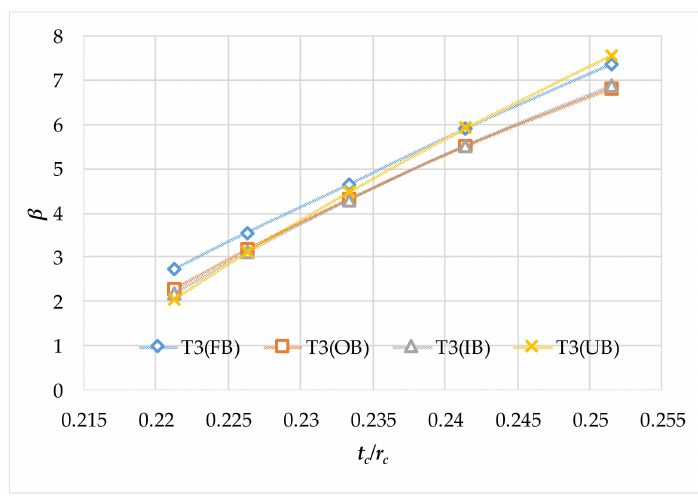
Figure 11. β as a function of core thickness ratio ( t c / r c